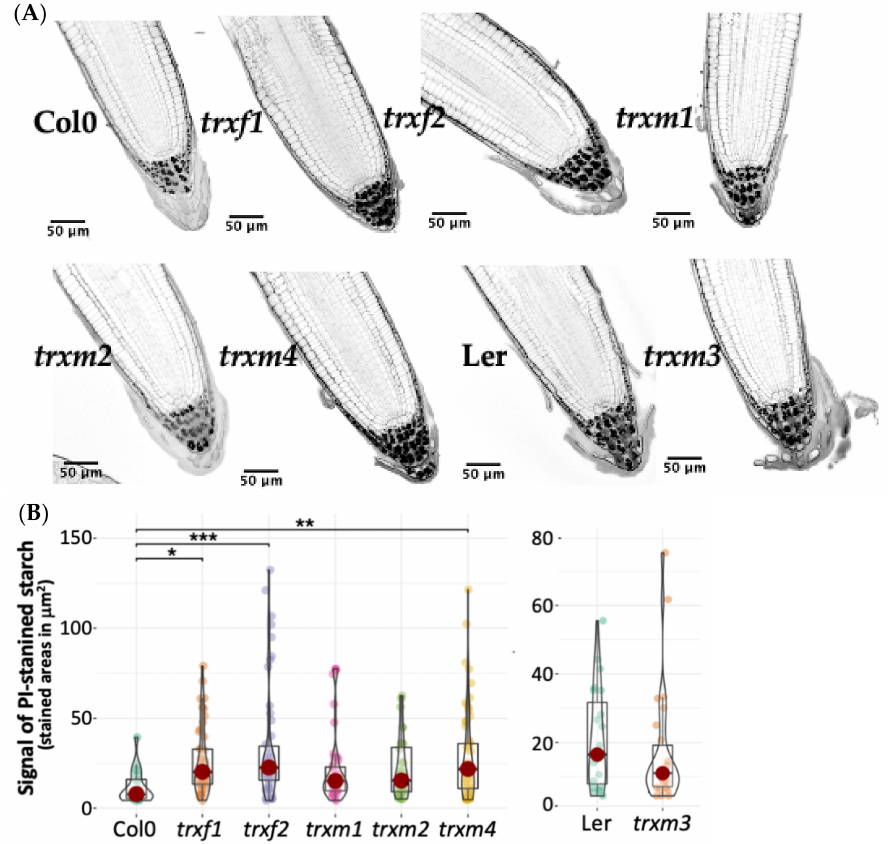
Figure 7. Root tip structure and starch signals in columella of WT (Col0 and Ler) and trxf and trxm mutant lines. ( A ) Root cells and starch granules were stained with propidium iodide (PI) and imaged with confocal microscopy. Arabidopsis seedlings were grown for 7 days. ( B ) Quantification of starch areas stained with PI (using the free software ImageJ 2.0.0). Asterisks above the violin graph indicate statistically significant differences (* p ≤ 0.05, ** p ≤ 0.01, *** p ≤ 0.001) as determined using